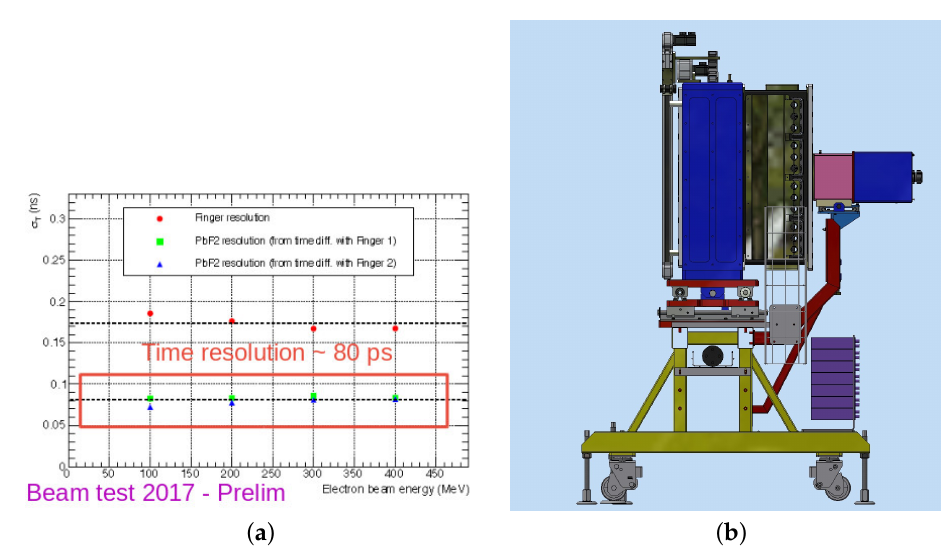
Figure 5. ( a ) SAC BTF test time resolution [23]; and ( b ) final SAC mounting (pink area on the right—followed by blue area of PMTs) together with the ECAL (blue area at center—followed by grey area of PMTs box) with all mechanical structure, including the HV distribution boxes in the right lower part (violet area) and the mechanical support structure (light